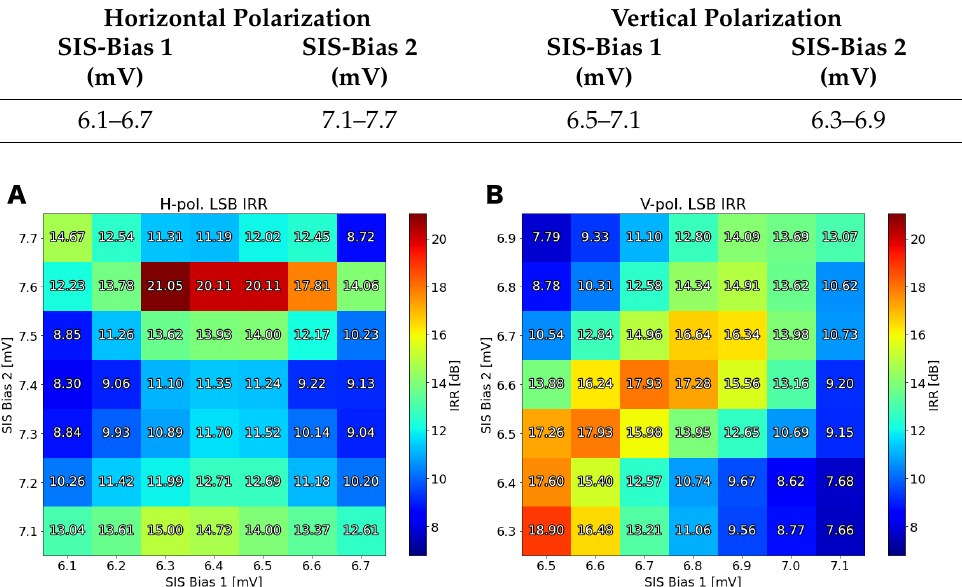
Figure 5. Result of search for the optimal values of SIS-Bias yielding high IRRs: ( A , B ) show the IRR maps of the horizontal and the vertical polarizations, respectively. Both horizontal and vertical axes show the search range of optimal bias for the SIS mixer. The color indicates the IRR obtained with each combination of SIS-Biases 1 and